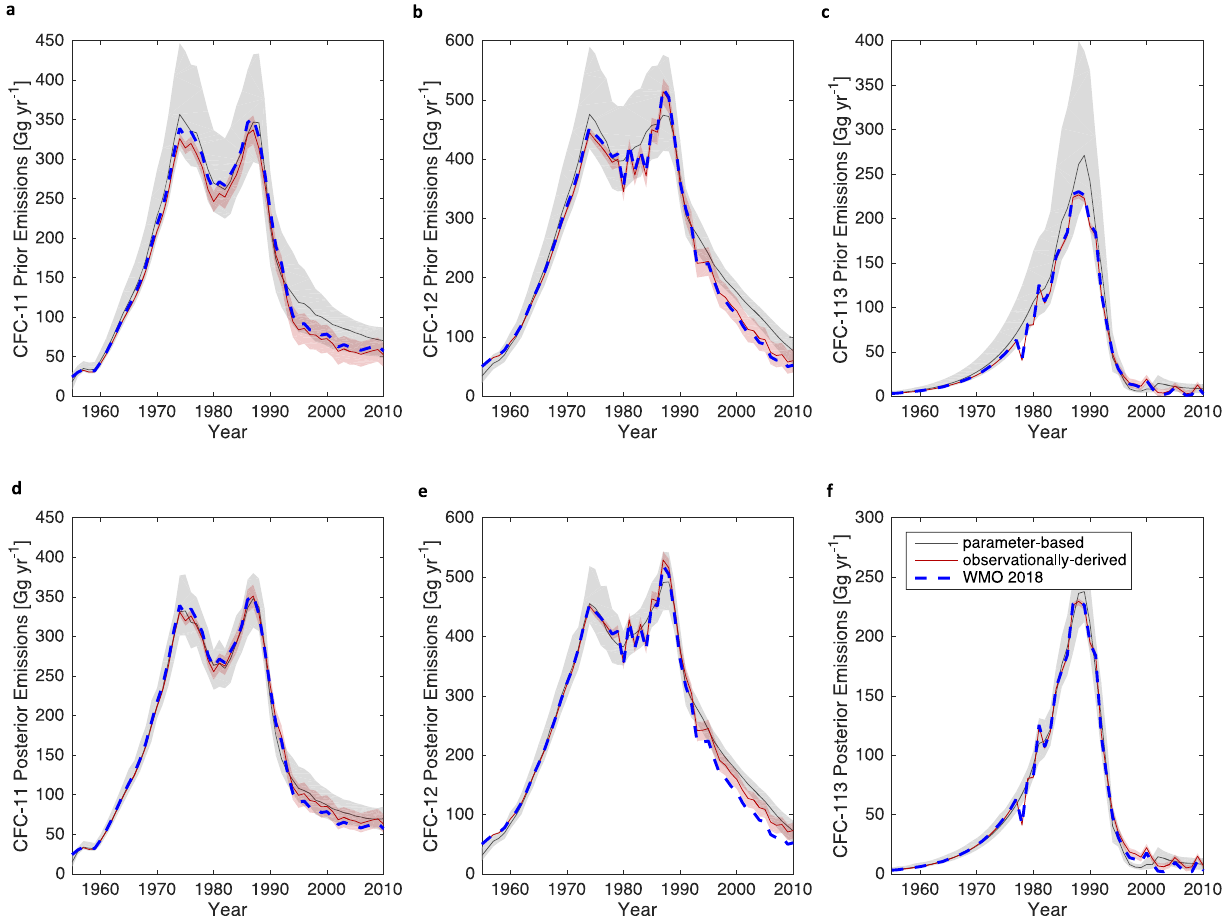
Fig. 3 Prior and posterior emissions and comparisons. Emissions comparisons of observationally-derived (red) and parameter-based (grey) inferred emissions for the priors ( a – c ) and posteriors ( d – f ). The solid lines indicate the median and the shaded region indicates the 95% CI for both prior and posterior distributions. The uncertainties in observationally-derived emissions re fl ect the role of uncertainties in lifetimes and thus are updated in the posterior to re fl ect the lifetime posterior estimates. The dashed blue line indicates global emissions estimates from WMO (2018) 3 , provided for comparison.